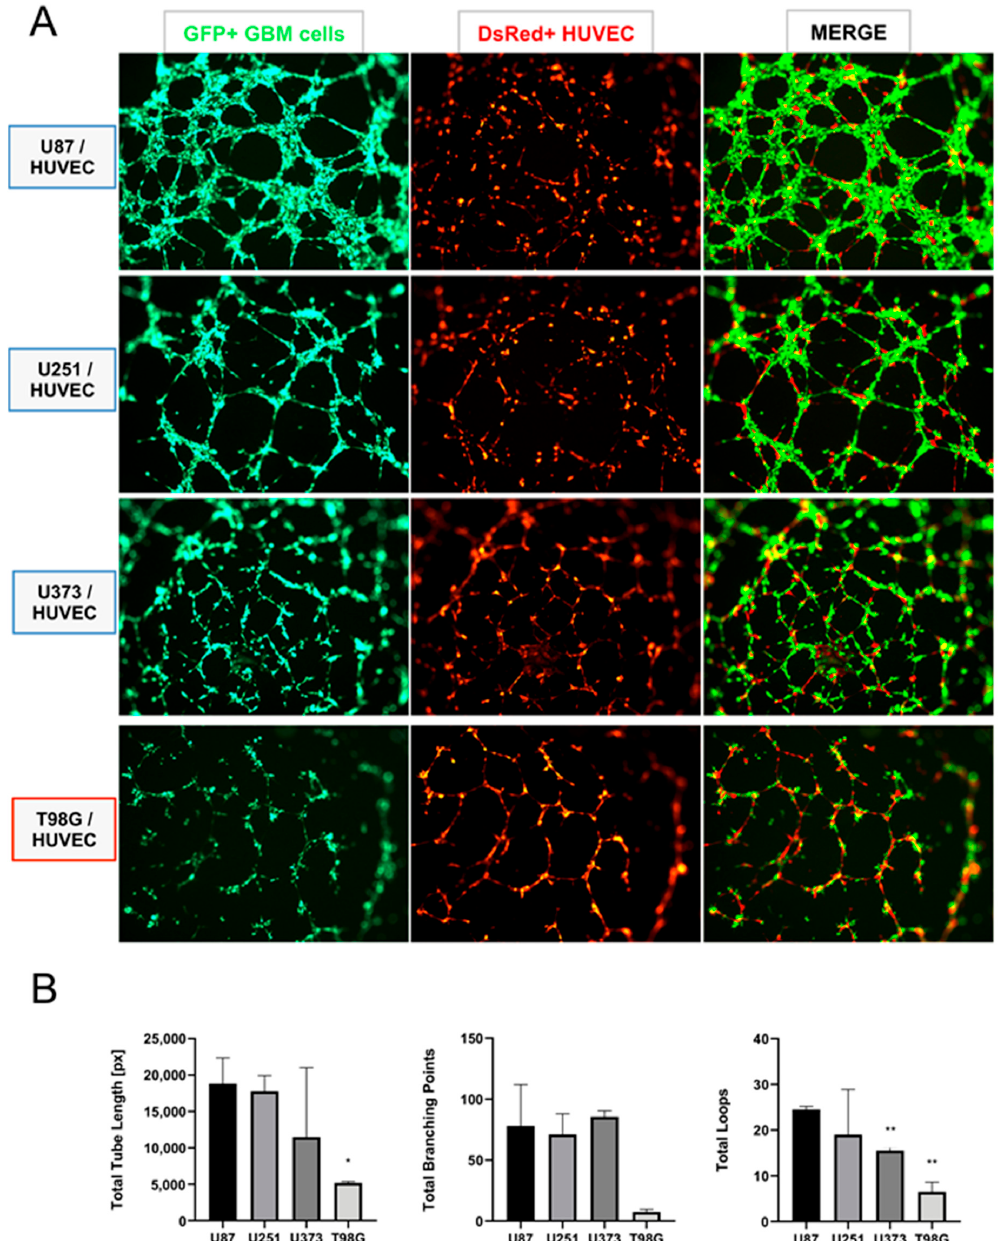
Figure 5. Behavior of GBM cells and HUVECs under co-culture conditions. ( A ) Representative images of a co-culture Matrigel assay containing GBM cells: U87-MG, U251-MG, U373-MG and T98G, from top to bottom (first column, green), co-cultured with HUVECs (second column, red). Third column is the resulting merge of GBM and HUVECs (associated images at time 0 are included in supplementary Figure S4); ( B ) graphs representing the WimTube quantification of several parameters comparing GBM cells under co-culture conditions: total tube length, total branching points and total loops ( n ≥ 3 images for all cell lines) (**, p < 0.01; and *, p < 0.05. U87-MG cultures were used as control for statistical